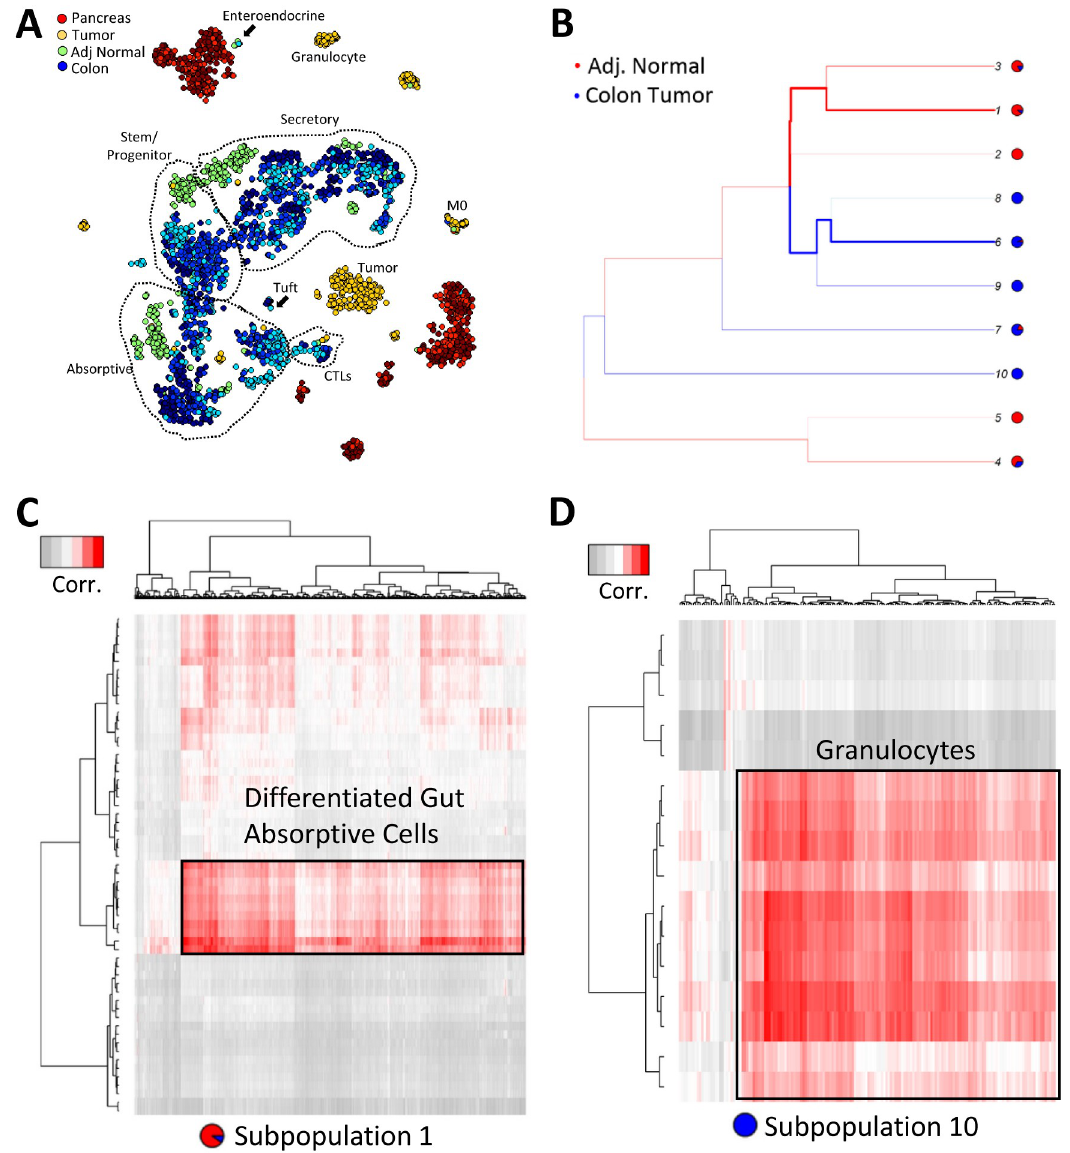
Fig 6. sc-UniFrac identifies unique cellular infiltrates within colonic tumor compared with normal colon. (A) t-SNE plot of multiple replicates of single-cell data from the pancreas, colonic tumor, adjacent normal colon, and normal colon analyzed together. Random sampling of 400 cells from each group. Populations delineated by marker genes. (B) Branching structure of tumor and adjacent normal landscapes scored by sc-UniFrac (k = 10). (C, D) Individual cells (columns) from subpopulations 1 (C) and 10 (D) of panel B being matched to cell types (rows) referenced from the Mouse Cell Atlas. Analysis similar to Fig 5. Data from GSE117615. t-SNE, t-distributed stochastic neighbor